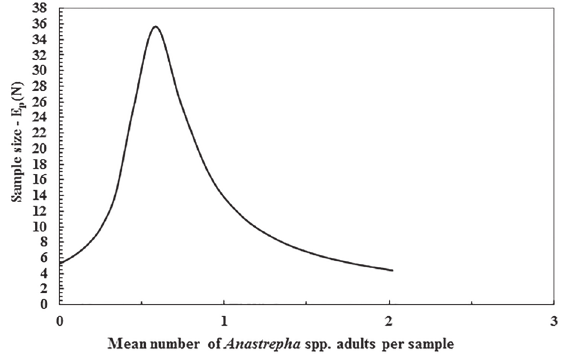
Figure 3 - Curve of Expected Size of Sampling Units Ep(n) of the Sequential Probability Ratio Test for populations of fruit fly species of the genus Anastrepha in ‘Novo Milênio’ guava cultivar for 23 weeks in three orchards in the region of Ivinhema, State of Mato Grosso do Sul, Brazil (August 2013 to January